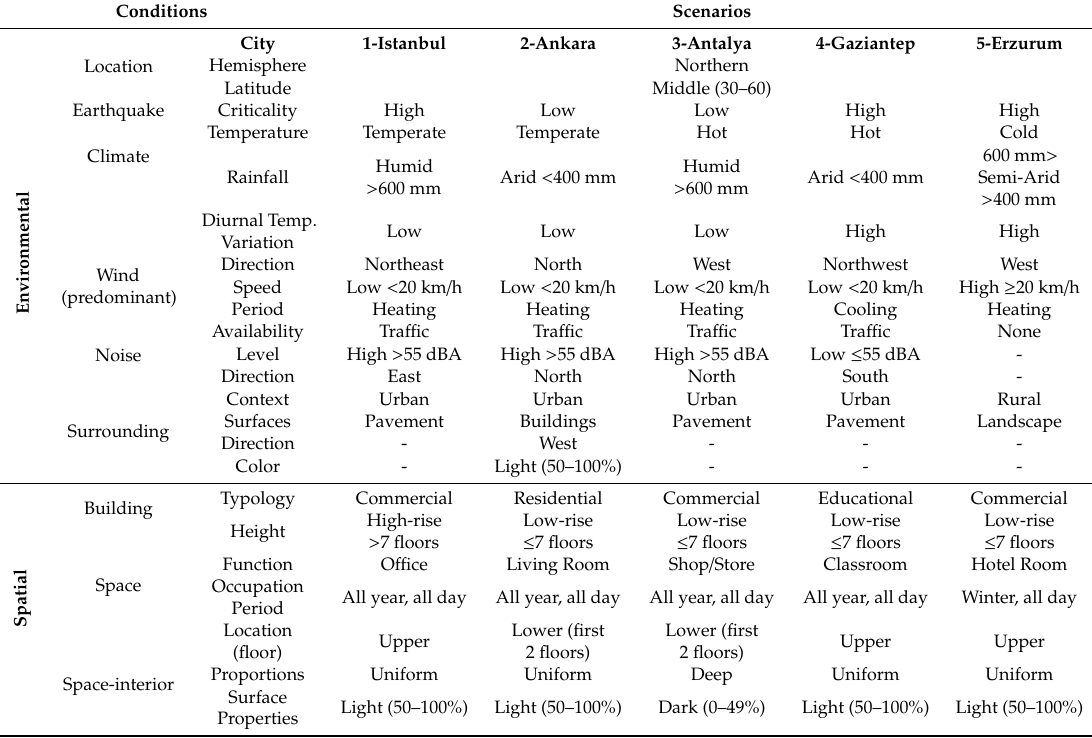
Table 2. Scenarios.